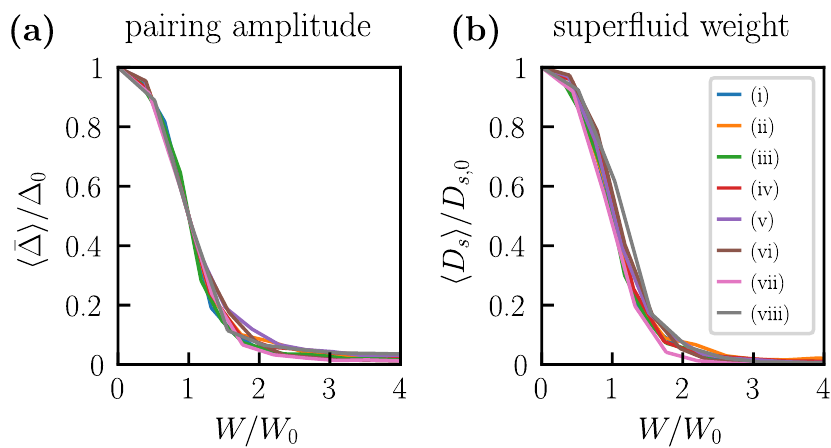
Figure 1: Universality of the disorder-induced suppression of the pairing amplitude and the superfluid weight across a variety of lattice models: (i)-(v) topological and trivial extended Kane-Mele models, (vi)-(viii) trivial single-band models (see text and Appendices C and G). The ensemble averages of (a) the spatial average of the pairing amplitude ¯ ∆ and (b) the superfluid weight D are shown as a function of the disorder s strength W / W 0